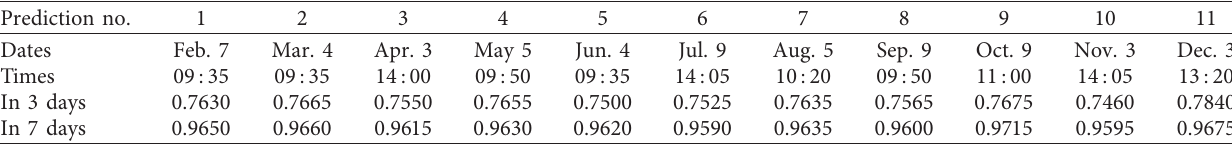
Table 7: Performances of the rolling window prediction of the SZ component index. Prediction no.